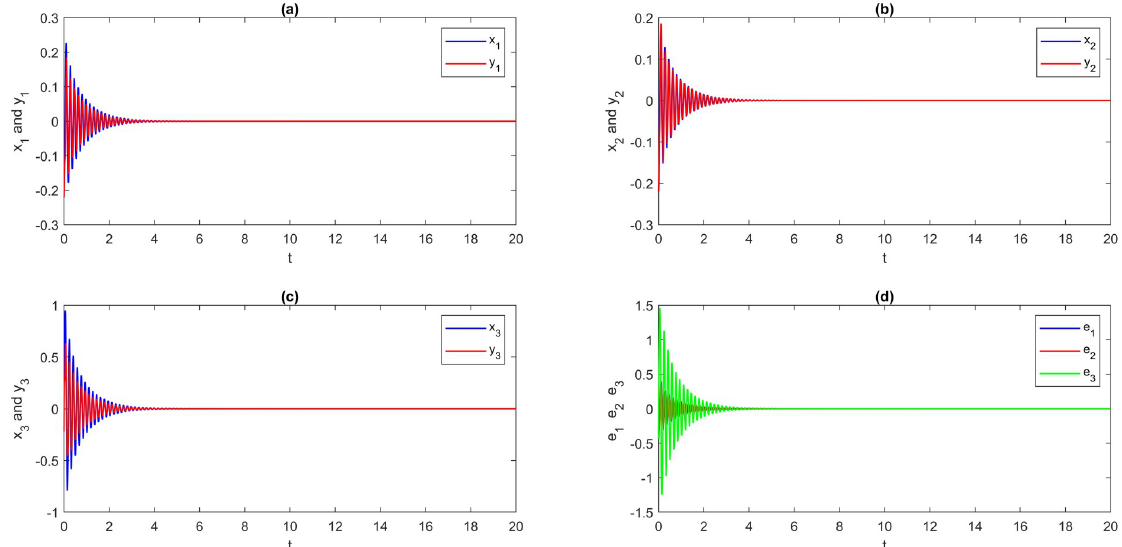
Fig 6. Without delay, multi-FONNSMD synchronization with controller activation. (a) x 1 versus y 1 , (b) x 2 versus y 2 , (c) x 3 versus y 3 , and (d) Synchronization error.